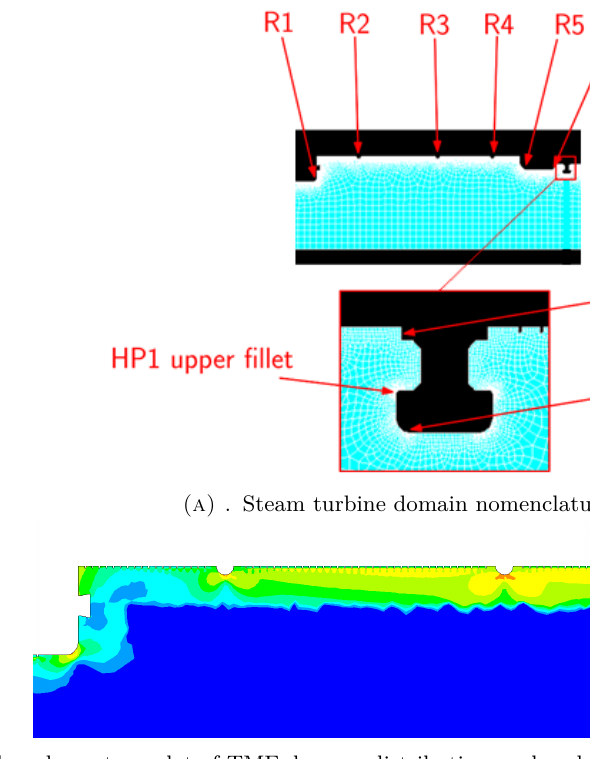
Figure 12. TMF prediction by the